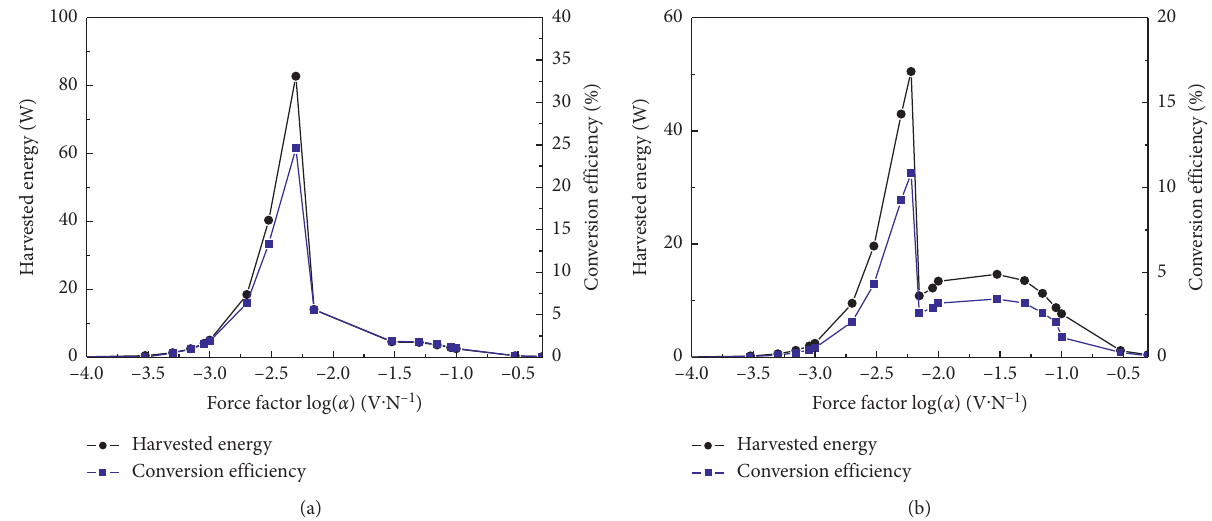
Figure 15: The harvested energy and conversion efficiency of the friction system with different force factors in the friction laws I (a) and II